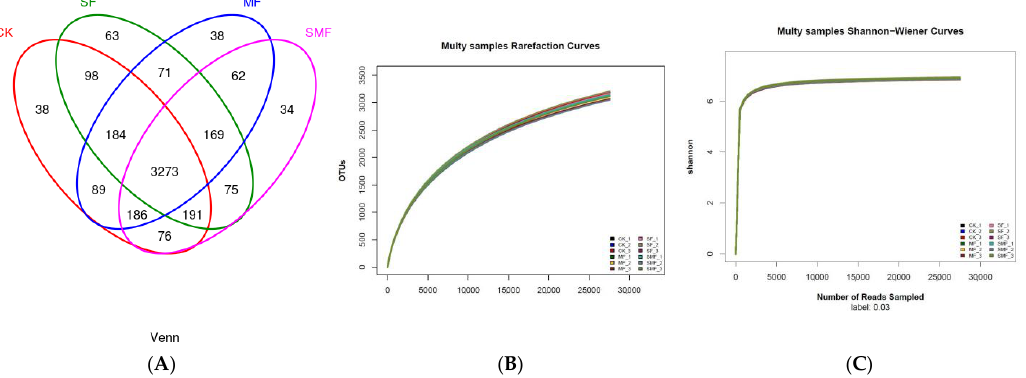
Figure 1. Venn diagram ( A ), dilution curve ( B ), and Shannon-Wiener curve ( C ) of soil bacterial community treated by silicon fertilizer and microbial